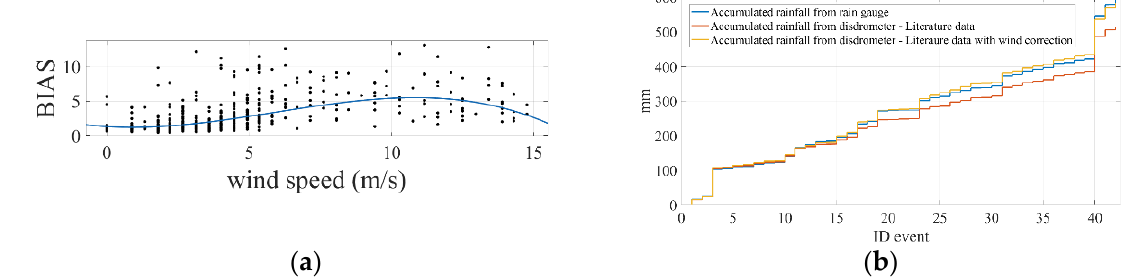
Figure 13. ( a ) Scatter plot between wind speed (m s − 1 ) and BIAS score. The latter has been computed according to Equation (7), using the 10-min average rain rate provided by the reference rain gauge and the disdrometer measurements obtained using the literature filtering method. Only light-rain cases are considered. The relationship between wind speed and BIAS has been modeled using a third-order polynomial fit (highlighted in blue). ( b ) Comparison, over the entire analyzed period, of 10-min cumulative precipitation sums (mm) between literature disdrometric data (red line), wind-corrected literature disdrometric data (yellow line) and the FAK010AA rain gauge (blue line).